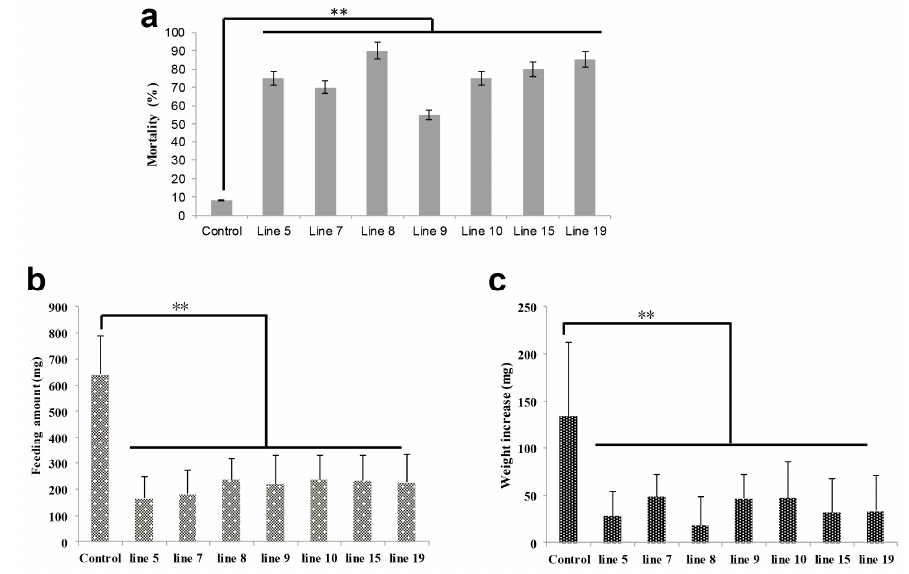
Figure 3. H. armigera mortality, feeding amount, and weight increase of 5th-instar larvae after feeding on transgenic cotton. Mortality ( a ), feeding amount ( b ), and weight increase ( c ) of 5th-instar larvae after feeding on different lines of transgenic cotton (lines 5, 7, 8, 9, 10, 15, and 19) for 3 days. Male parent F15 cotton was used as a control. Error bars represent mean ± SD. Essentially identical results were obtained across three independent experiments. Asterisks indicate significant differences from the control (** p < 0.01).